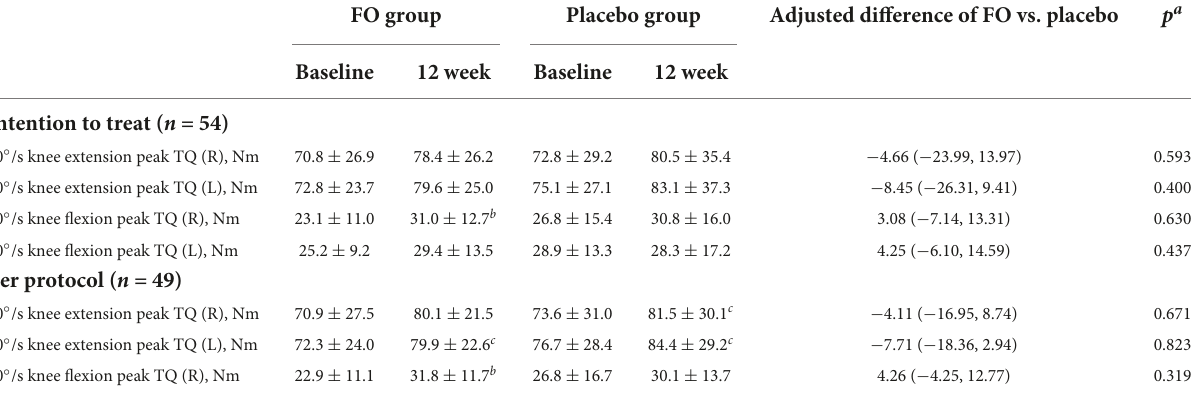
TABLE 3 Primary outcome measures of the two groups. FO group Placebo group Adjusted difference of FO vs. placebo p